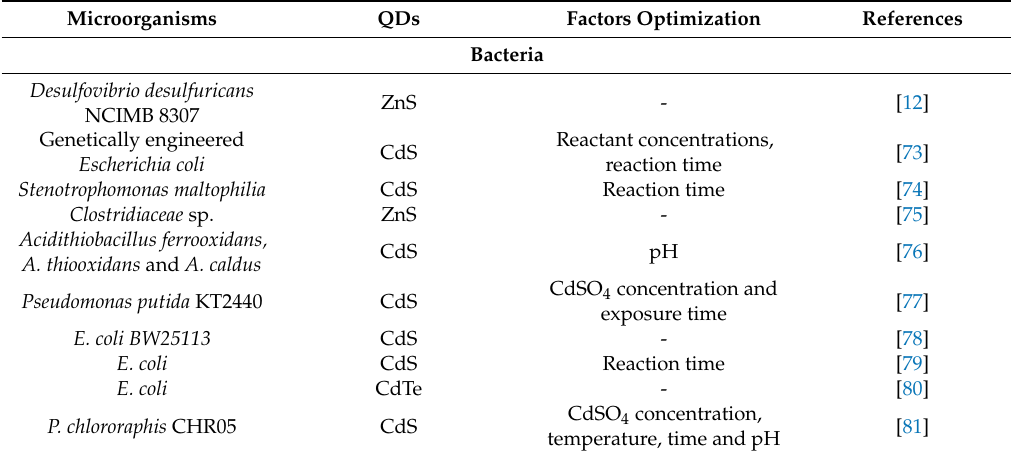
Table 1. List of microorganisms (bacteria, yeast, and fungi) mediating quantum dots (QD) production and di ff erent types of microbially-produced